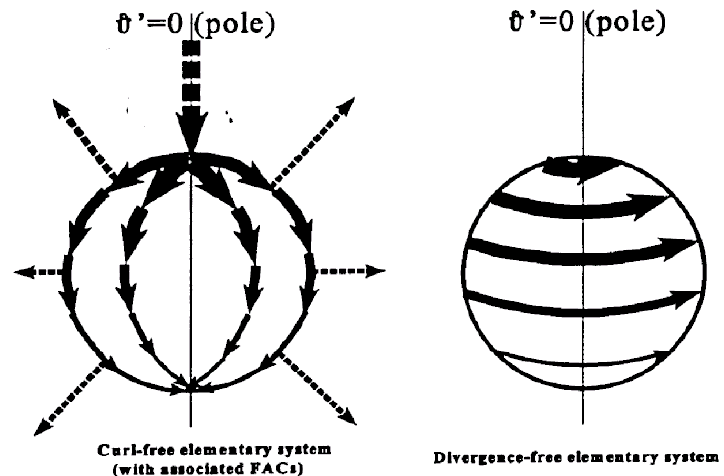
Fig. 2. Two spherical elementary cur- rent systems used by Amm and Vilja- nen (1999), the curl-free part (left) and the divergence-free part (right). The divergence-free part is used in this study as a model for the current